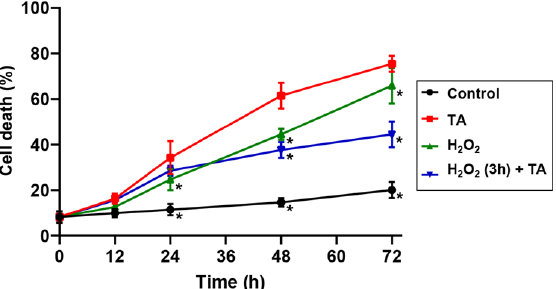
Figure 3. Induction of cell death by thaxtomin A and H 2 O 2 . Percentage of cell death in Arabidopsis suspension-cultured cells 48 hours after treatment with 0.1% methanol (Control, black circle), 1 µM thaxtomin A (TA, red square), 1 mM H 2 O 2 (green triangle), and 3 hour-pretreatment with 1 mM H 2 O 2 followed by 1 µM TA (blue inverted triangle). Cells were counted in groups of 500 and the mean ± SD was calculated from three replicates. Data was analyzed using one-way ANOVA. A significant difference with TA treatment for each time point ( p < 0.05) is indicated by an asterisk (*).